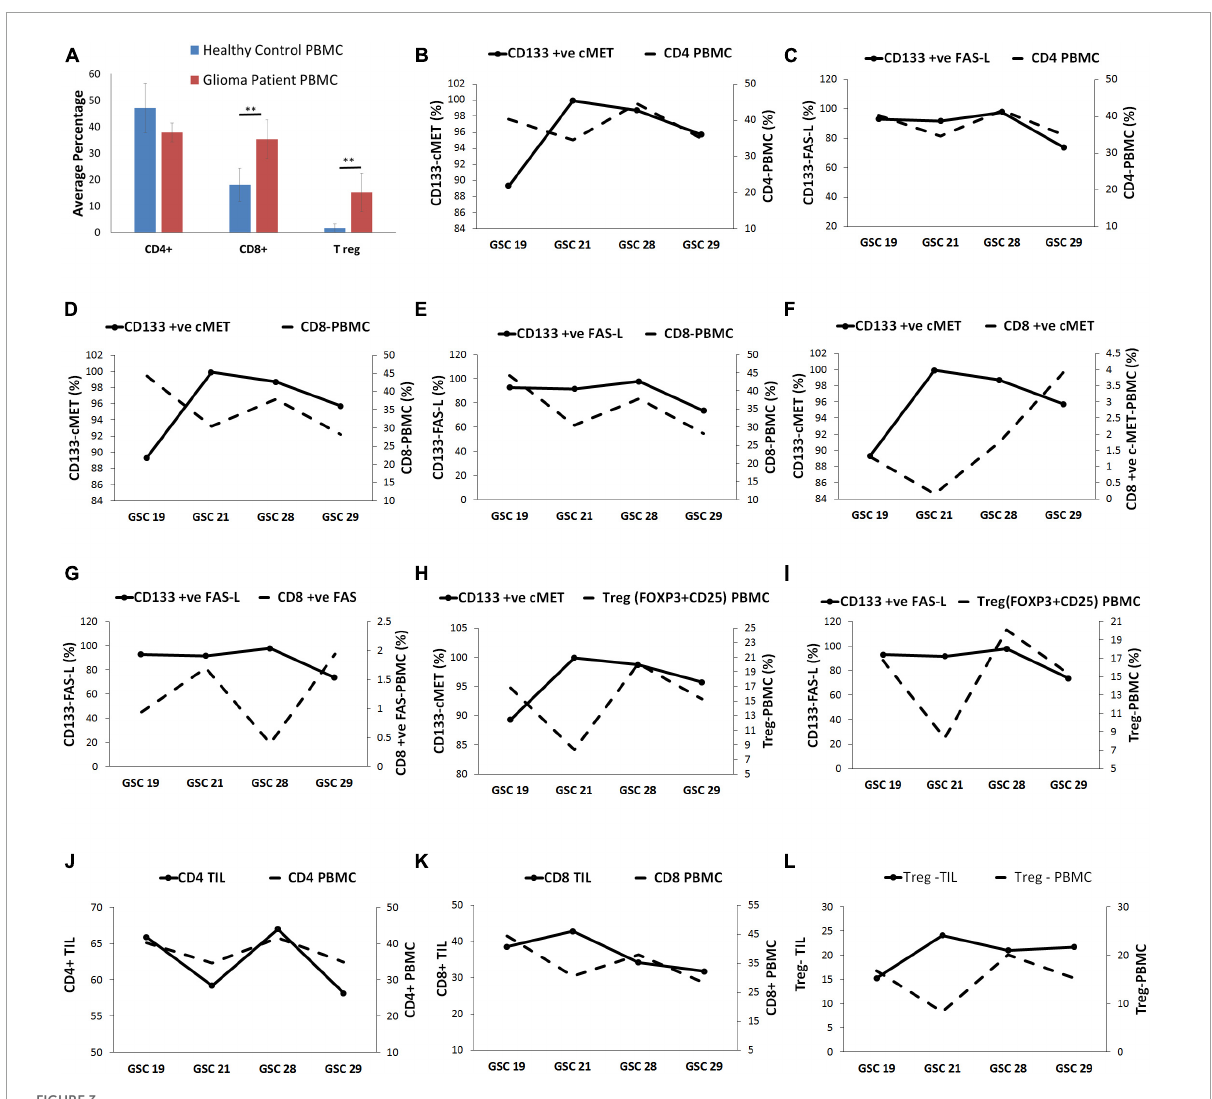
FIGURE3 Glioma stem cells were linked with a systemic immunosuppressed phenotype of glioblastoma patients. (A) The immune cell frequency distribution in glioma patients and healthy controls. (B) The CD4 + PBMCs displayed inverse relation with CD133 + c-Met-GSCs except for GSC 29 sample. (C) CD4 + PBMCs were directly related to CD133 + FasL-GSCs. (D) The CD8 + PBMCs were inversely related to CD133 + c-Met GSCs except for GSC 29. (E) The CD8 + PBMCs are directly related to CD133 + FasL-GSCs. (F) CD8 + ve c-Met-PBMC were inversely related to CD133 + c-Met-GSCs. (G) CD8 + ve Fas-PBMC were inversely related to CD133 + Fas-L-GSCs. (H) T reg PBMCs were inversely related to CD133 + c-Met-GSCs except for GSC 29. (I) T reg PBMCs were directly related to the CD133 + Fas-GSCs. (J) CD4 + TIL was directly related to the CD4 + PBMC. (K) CD8 + TIL were inversely related to CD8 + PBMC. (L) T reg-TIL was inversely related to T reg PBMC. ∗∗ p < 0.01 represent significant difference compared between patients and healthy